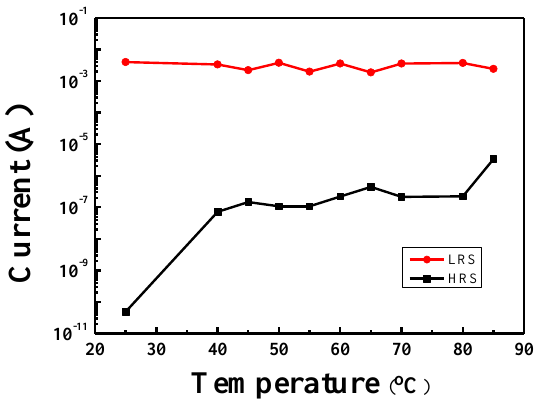
Figure 12. The typical resistive switching current–voltage curve of Al / MZN NR / ITO RRAM device at di ff erent environmental temperatures.